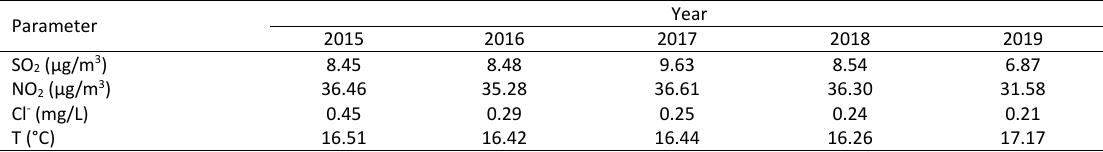
], [NO ], [Cl - ] and T annual average in the period 2 2